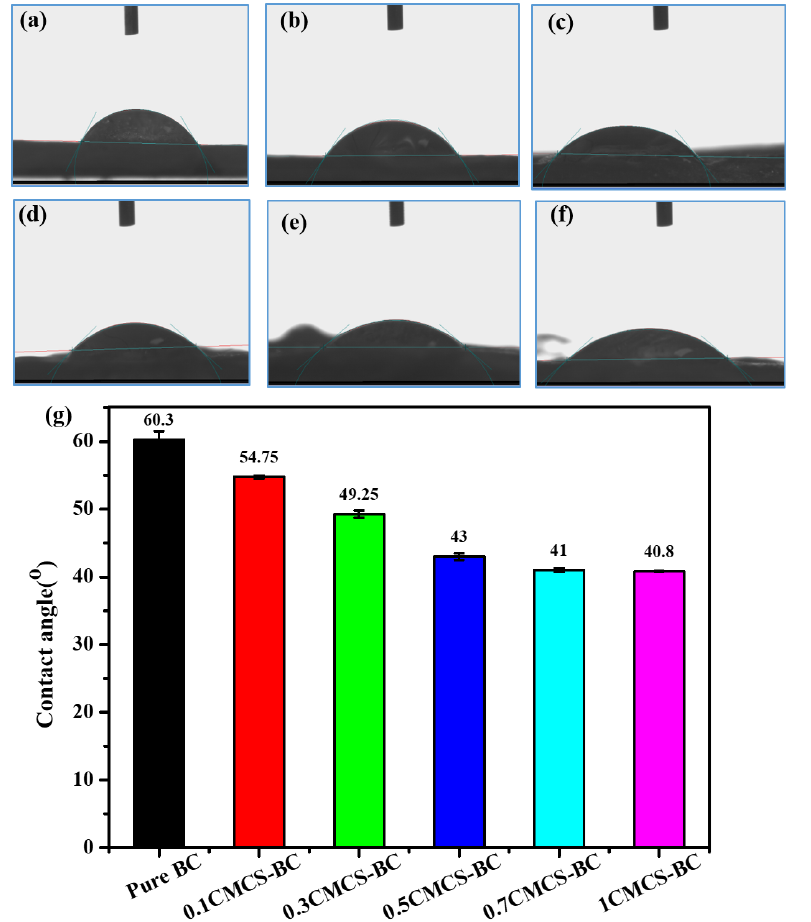
Figure 4. Water contact angle of ( a ) pure BC, ( b ) 0.1CMCS–BC, ( c ) 0.3CMCS–BC, ( d ) 0.5CMCS–BC, ( e ) 0.7CMCS–BC, and ( f ) 1CMCS–BC hydrogels and ( g ) their average values.